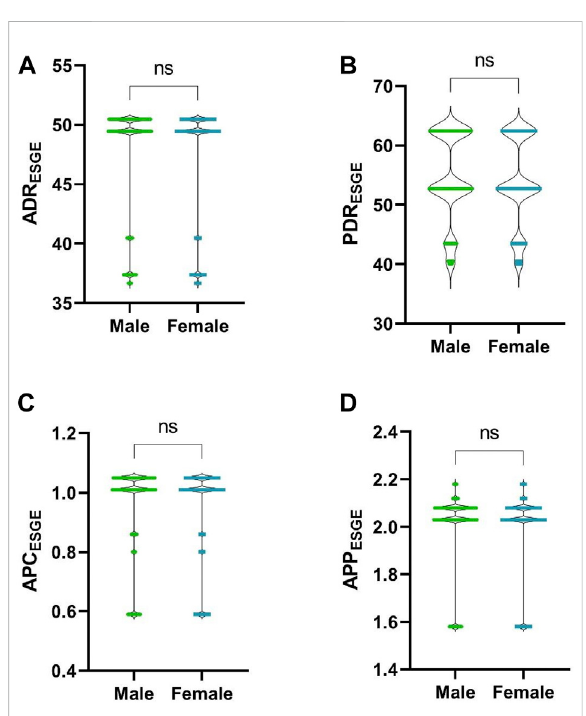
FIGURE 3 Comparisonbetweensedatedandnon-sedatedpatients. (A)